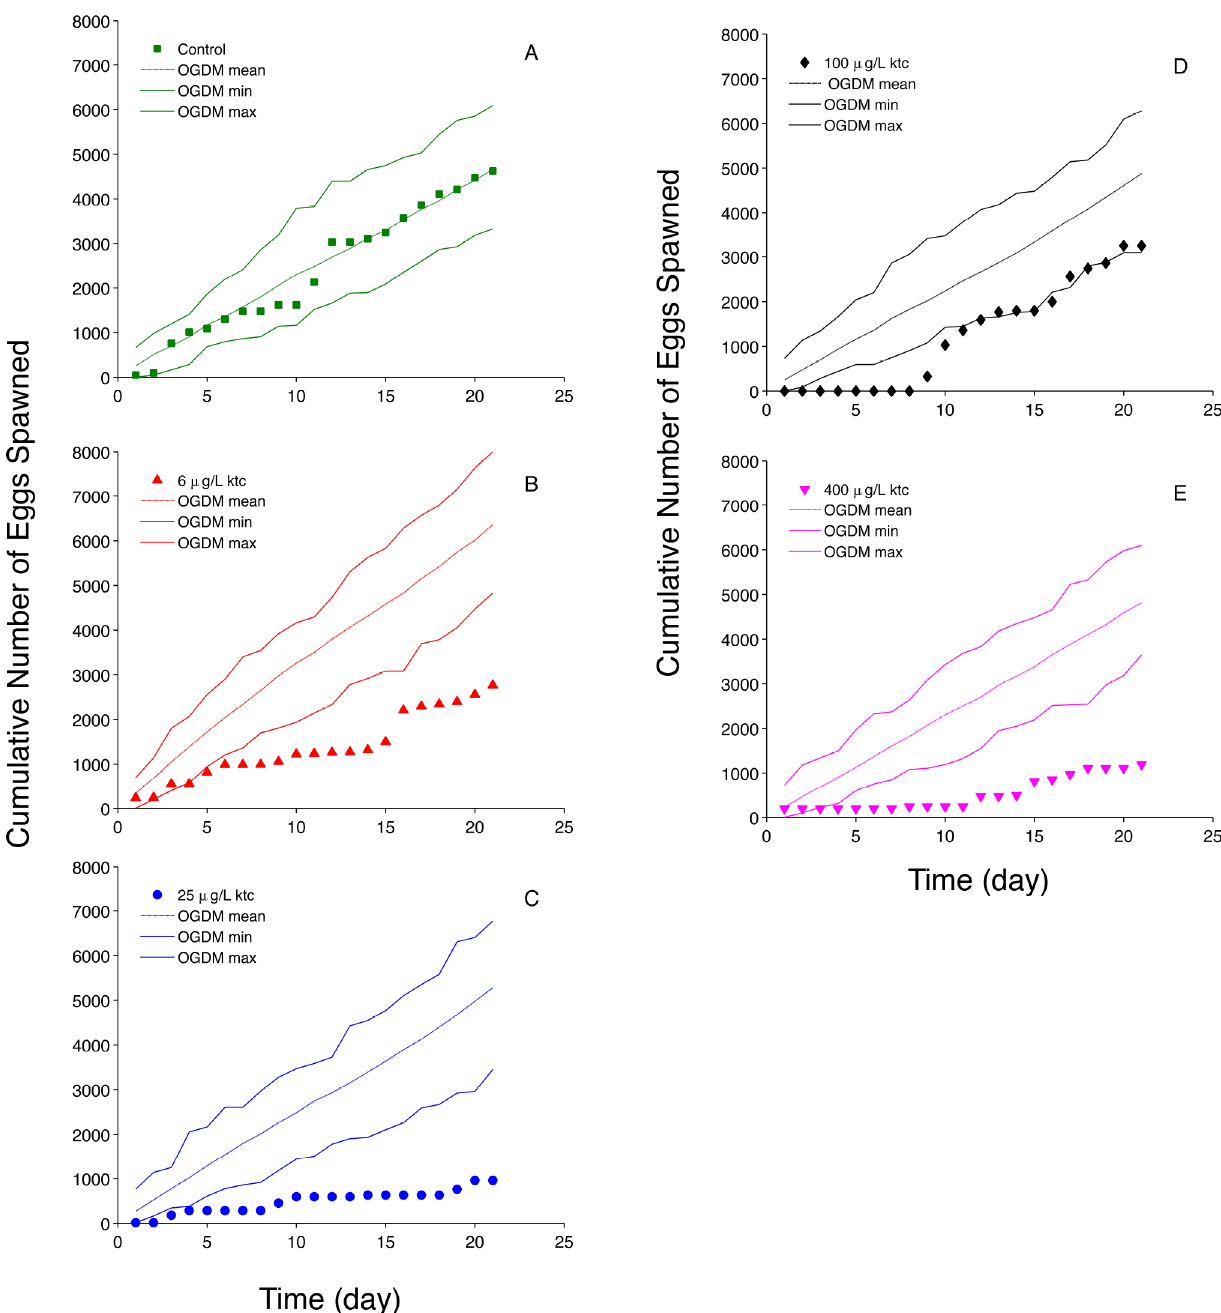
Fig 6. Ketoconazole (ktc) Cumulative Fecundity. (A) control (0 μ g ktc (cid:129) L -1 ); (B) 6 μ g ktc (cid:129) L -1 ; (C) 25 μ g ktc (cid:129) L -1 ; (D) 100 μ g ktc (cid:129) L -1 ; and (E) 400 μ g ktc (cid:129) L -1 exposure. Filled markers represent experimental data [12]; dashed lines represent the mean of 50 cumulative fecundity OGDM predictions; solid lines represent the minimum and maximum cumulative fecundity values of 50 OGDM predictions.